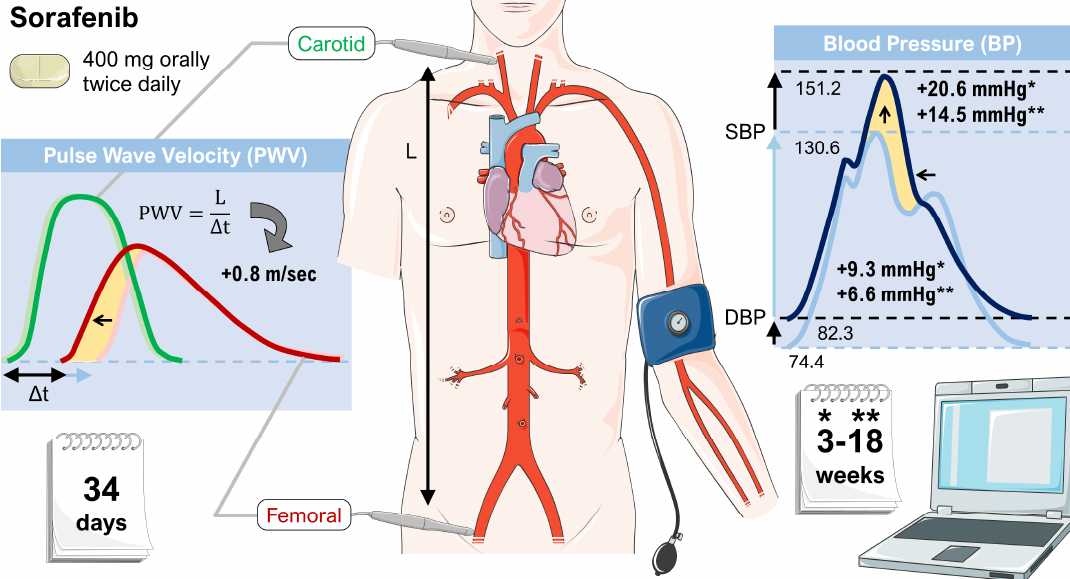
Figure 2. Effects of sorafenib on vascular stiffness. Patients treated with sorafenib showed an increase in systolic blood pressure (SBP) and diastolic blood pressure (DBP) as well as an elevation of the pulse wave velocity (both indicated by yellow areas). Sorafenib was administered to patients continuously at a dose of 400 mg twice daily. The data is based on a subset of patients enrolled onto a phase II randomized discontinuation clinical trial [41]. Parts of the figure were drawn by using pictures from Servier Medical Art.